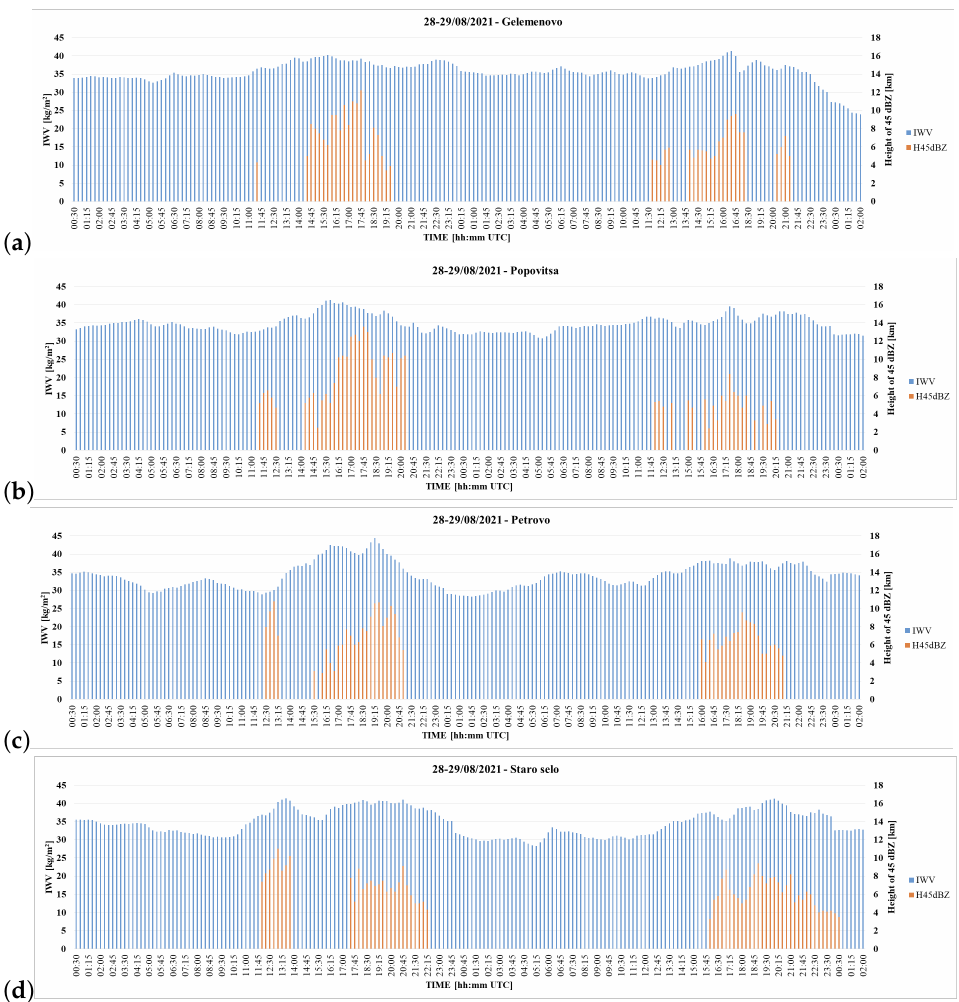
Figure 8. IWV (blue bars) and the altitude of 45 dBz (orange bars) at ( a ) Gelemenovo, ( b ) Popovitsa, ( c ) Petrovo and ( d ) Staro selo on 28–29 August